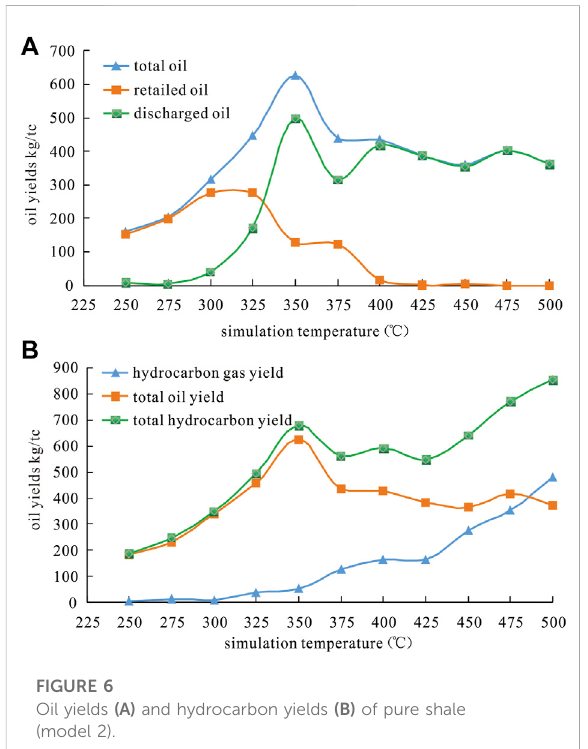
FIGURE 6 Oil yields (A) and hydrocarbon yields (B) of pure shale (model